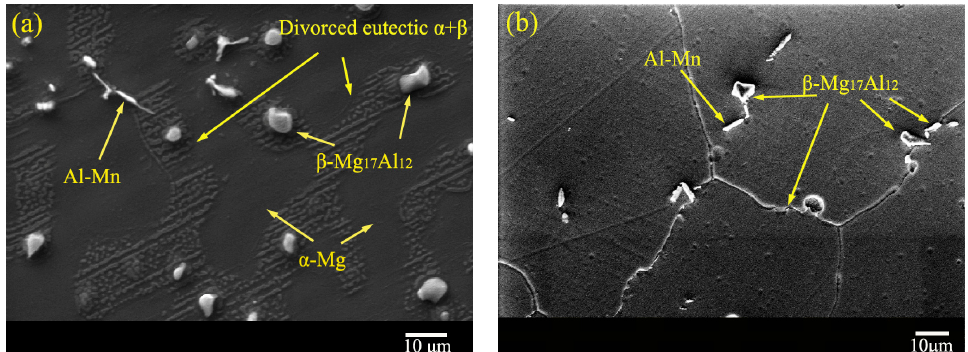
Figure 2. XRD results of the as-cast and solid-solution-treated AM50 magnesium alloy samples.